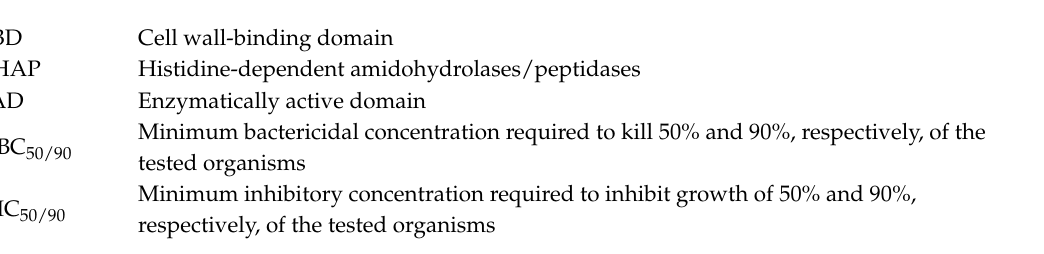
Table S1: MIC and MBC values of HY-133 and oxacillin for clinical S. aureus pairs OM299 and 4652 comprising WT isolates and their clonally identical SCVs as well as of the 6850-derived triplet for the evaluation of time-kill